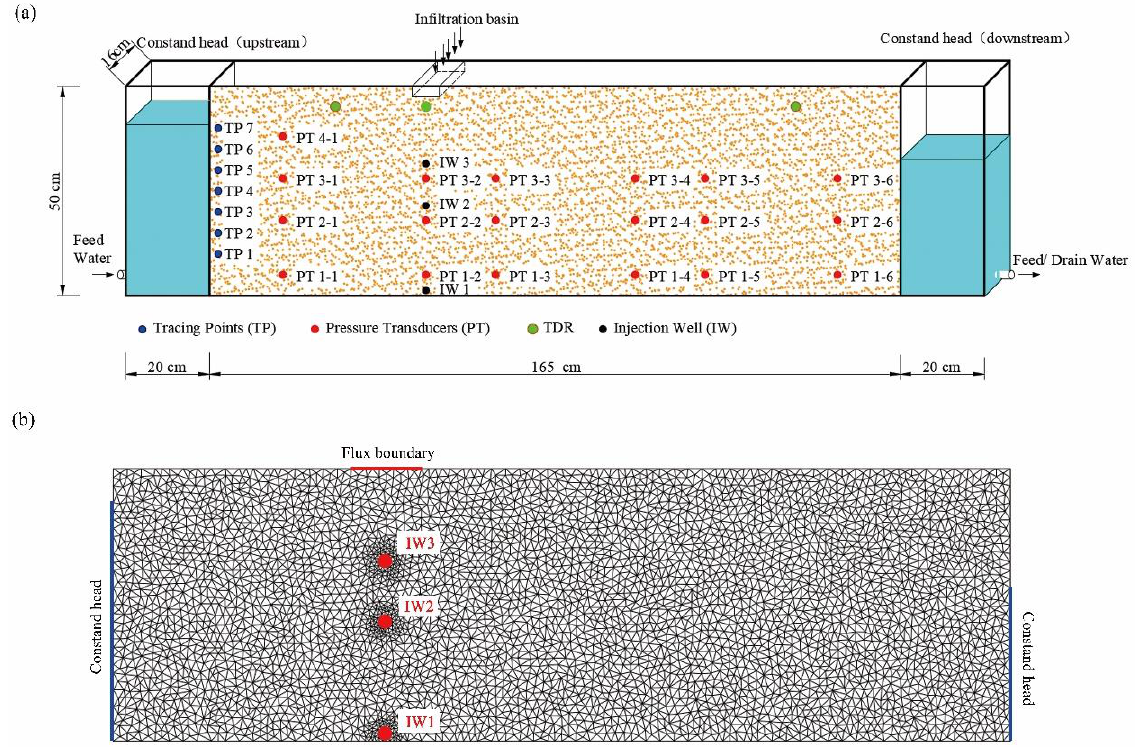
Figure 1. ( a ) Schematic diagram of the sand tank and the experimental apparatus; ( b ) side view of the laboratory-scale numerical model setup with prescribed boundary conditions. The boundaries on the right and left sides were set to a constant head boundary condition. The 19 red points in ( a ) are the pressure transducers for the hydraulic head data acquisition. The three black points in ( a ) are the injection wells. The red line in ( b ) on the top boundary was set to a flux boundary condition. The three red points in ( b ) are injection wells.